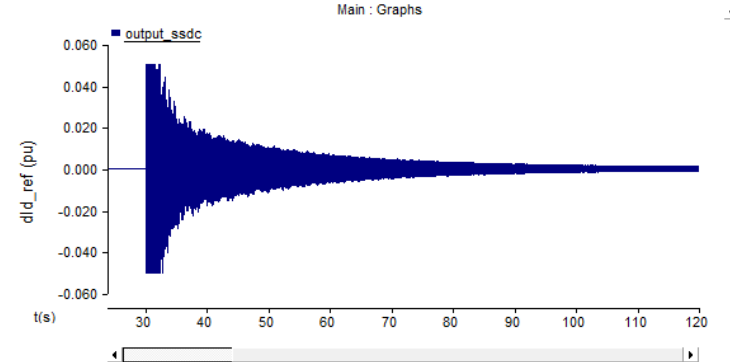
, of SSDC during its action. 𝑑_𝑟𝑒𝑓